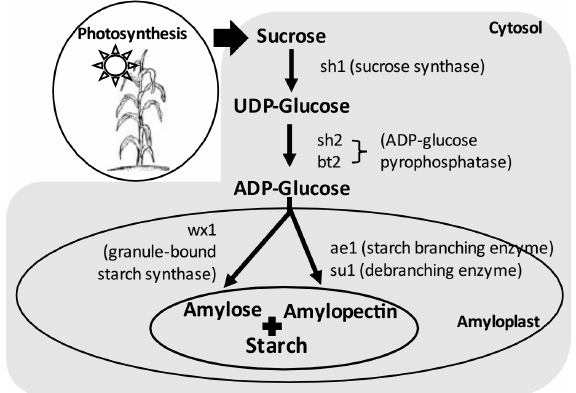
Figure 4. Diagram of starch biosynthesis pathway.